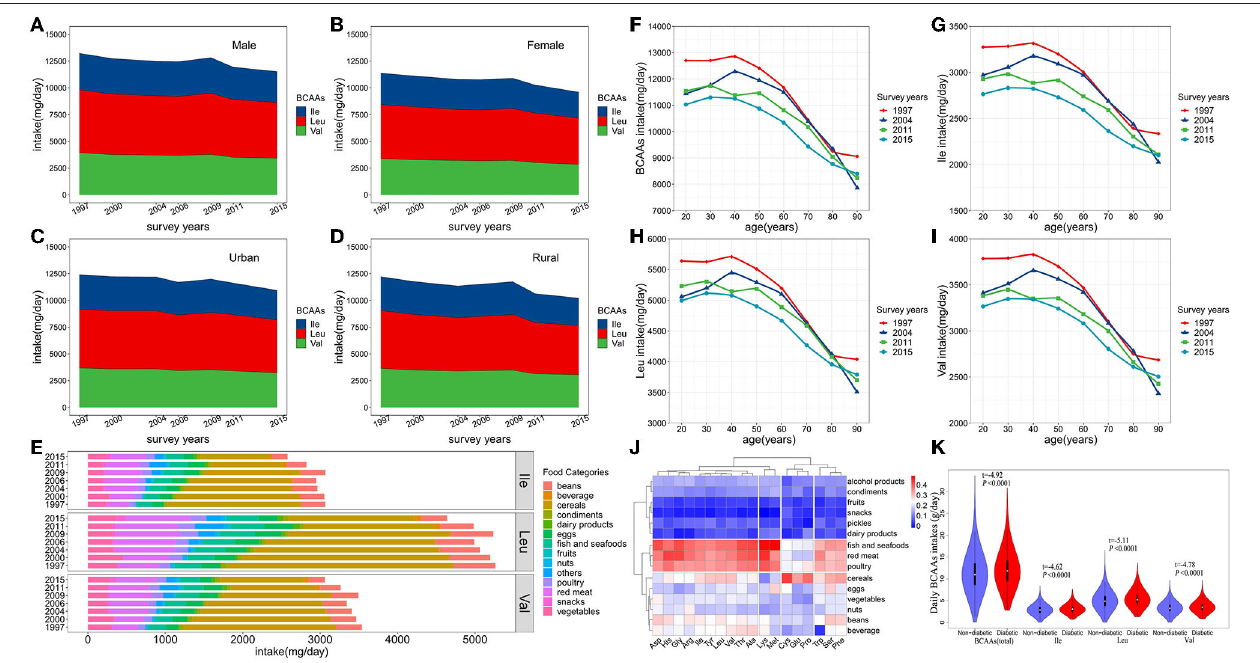
FIGURE 1 | (A–D) Trends in consumption of BCAAs and food sources from 1997 to 2015. P value for the trend, P < 0.0001 (Male, Female, Urban, Rural). (E) Food sources of dietary BCAAs. (F–I) Average daily BCAAs (Ile, Leu and Val) intakes in adults (aged 18–90 years) during 1997-2015. (J) Clustering and correlation heat map between dietary amino acids and food categories. (K) Comparison of BCAAs intakes between the diabetic onset group and non-onset group in the cohort.